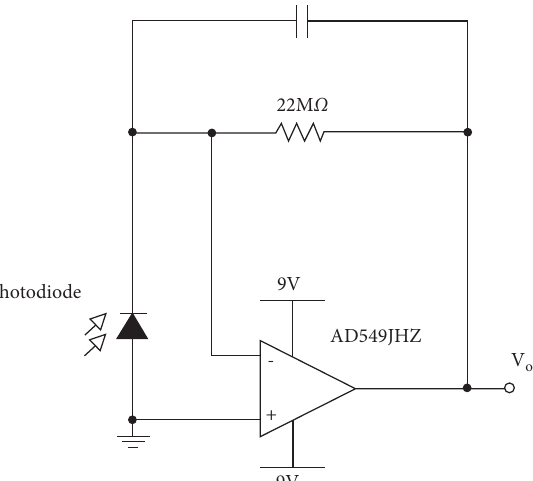
Figure 5: Transimpedance